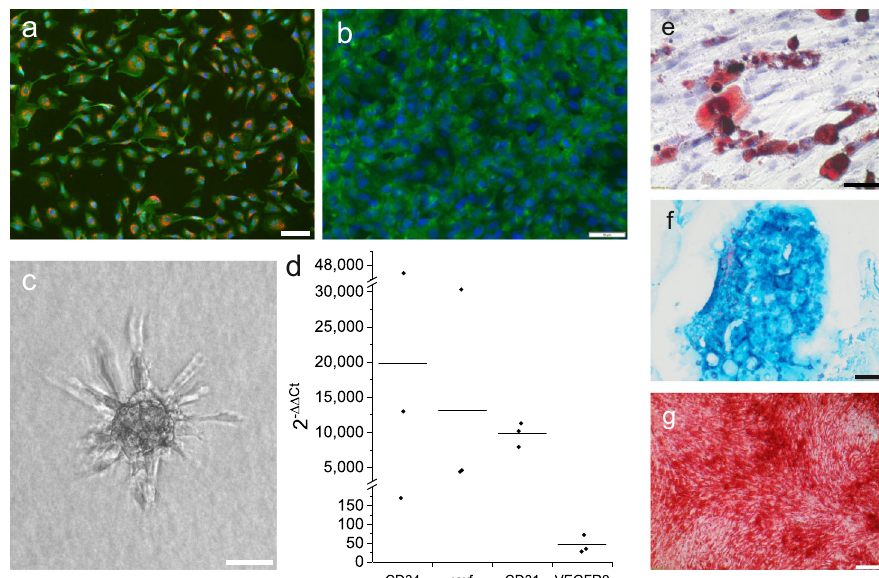
Fig. 1 Characterization of sheep EPC and MSC. a EPC after uptake of acetylated LDL-DiI (red) and lectin staining (green). Counterstaining with DAPI (blue). Scale bar 50 µm. b CD34 immuno fl uorescence staining (green) of EPC. Counterstaining with DAPI (blue). Scale bar 50 µm. c Sprouting of EPC spheroids after 48 h incubation in a fi brin gel. Scale bar 50 µm. d mRNA expression of EPC compared to MSC (set to 1). e Oil Red O staining of MSC after adipogenic differentiation. Scale bar 100 µm. f Alcian Blue staining of MSC after chondrogenic